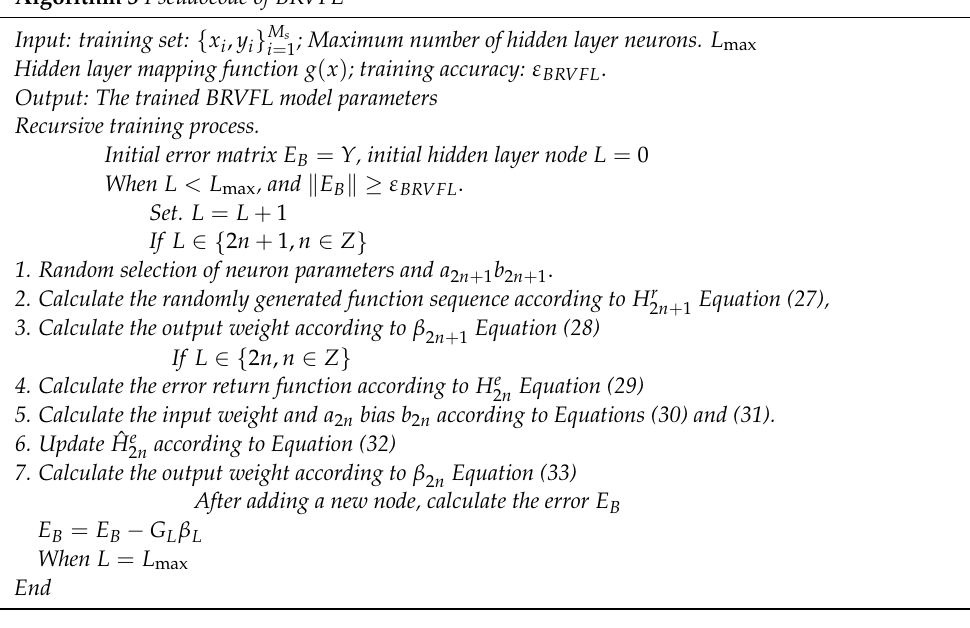
Algorithm 3 Pseudocode of